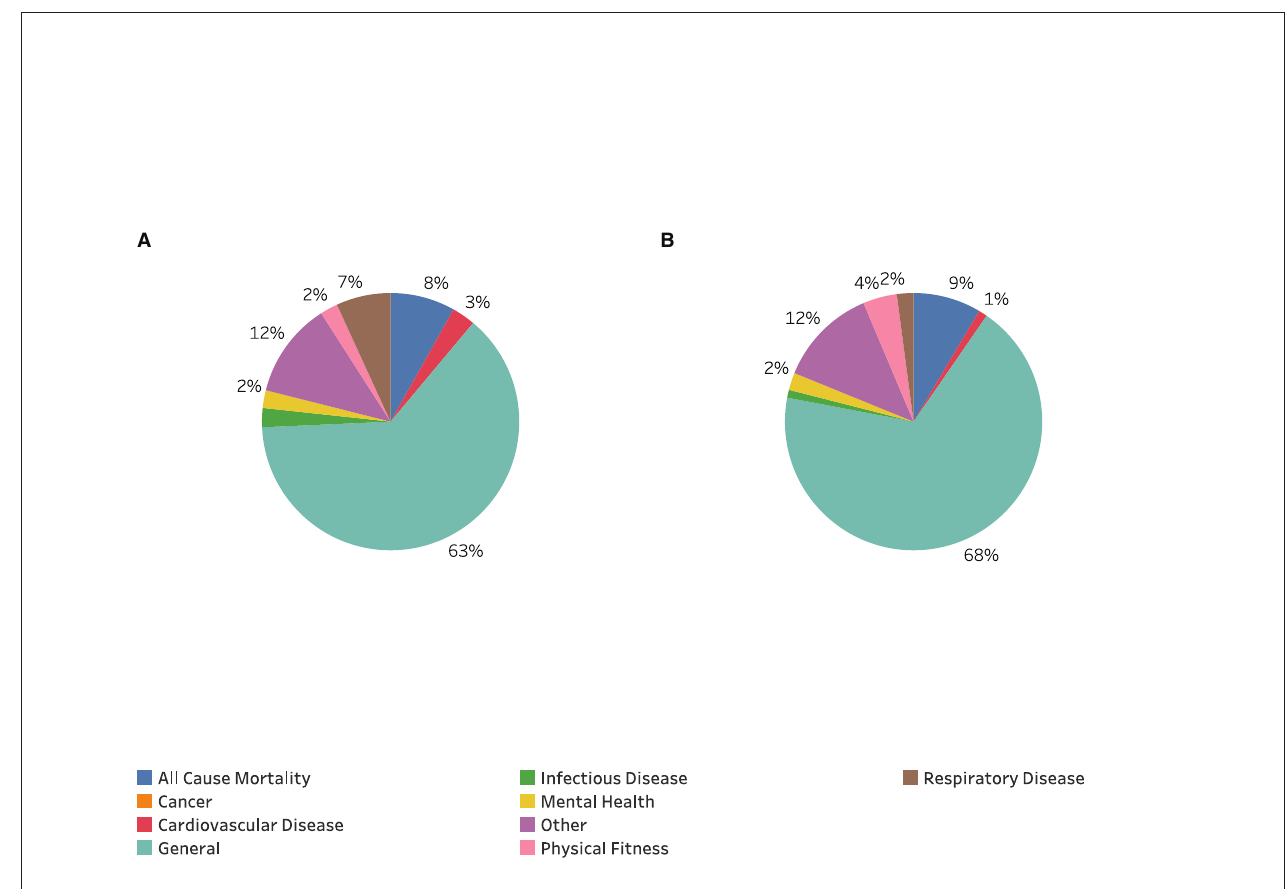
FIGURE 6 | Percent of health references by sub-category across all included cities for (A) health effects of climate change and (B) health co-benefits of GHG mitigation